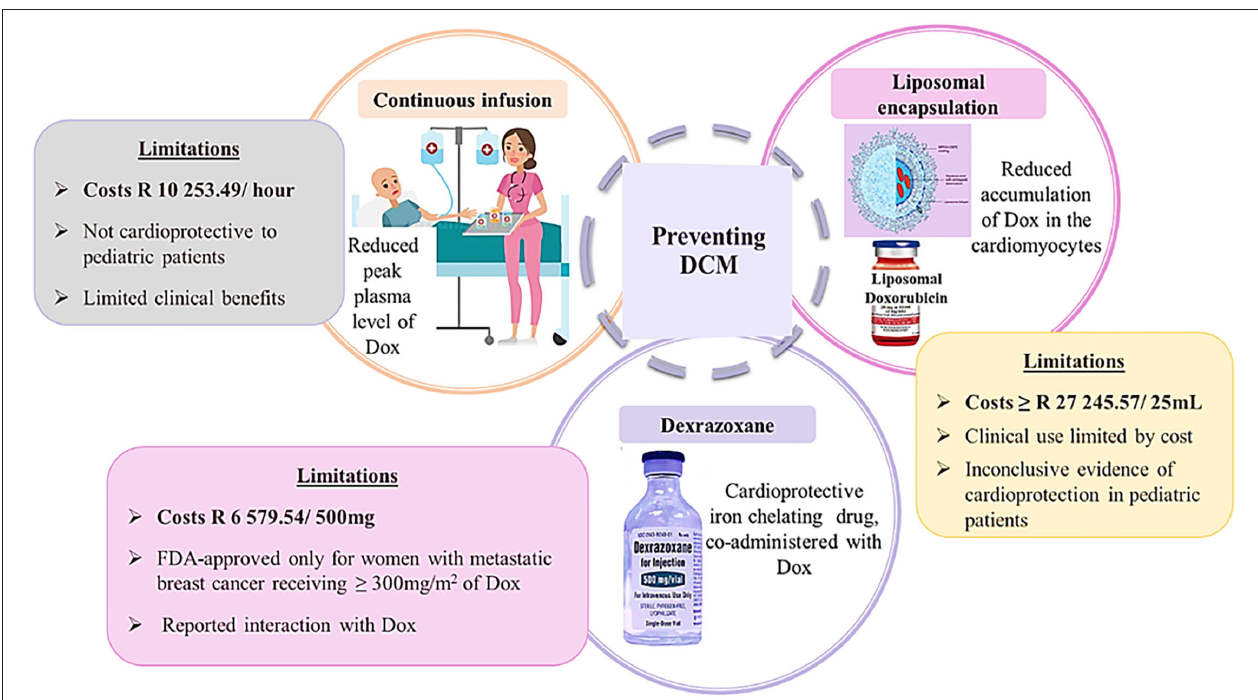
FIGURE 5 | Schematic presentation of preventative strategies of doxorubicin-induced cardiomyopathy. Image adapted from dreamstine.com.